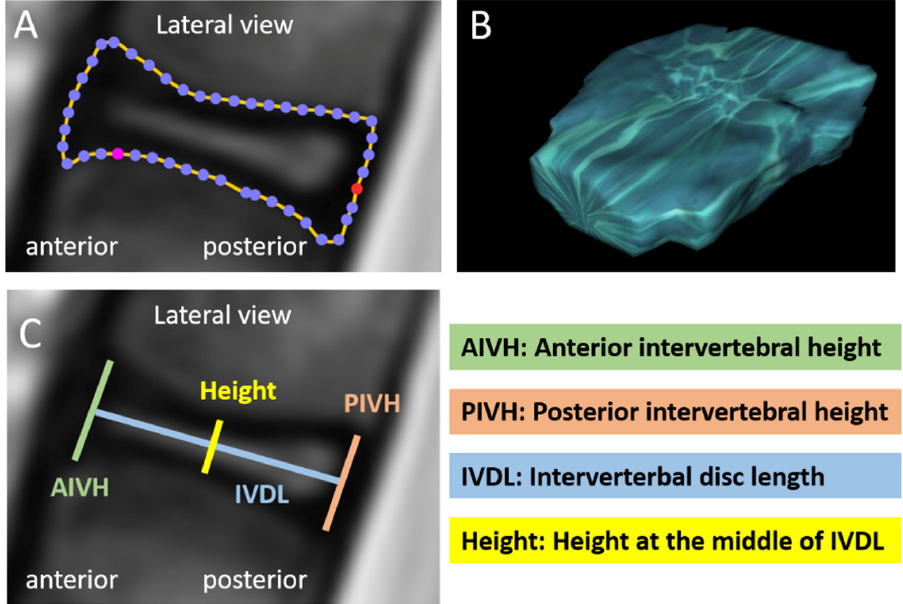
Figure 3. Measurements of intervertebral disc volume and intervertebral space dimensions. Inter- vertebral disc volume was determined by manual drawing of intervertebral disc circumference on each individual plane of the MRI scan ( A ) and subsequent software-based volume calculation ( B ). Intervertebral space dimensions were anterior intervertebral height (AIVH), posterior intervertebral height (PIVH), intervertebral disc length (IVDL) and height at the middle of IVDL. These param- eters were measured on each individual plane of lateral MRI images ( C ) in order to use them for formula-based calculation of the intervertebral space volume (Figure